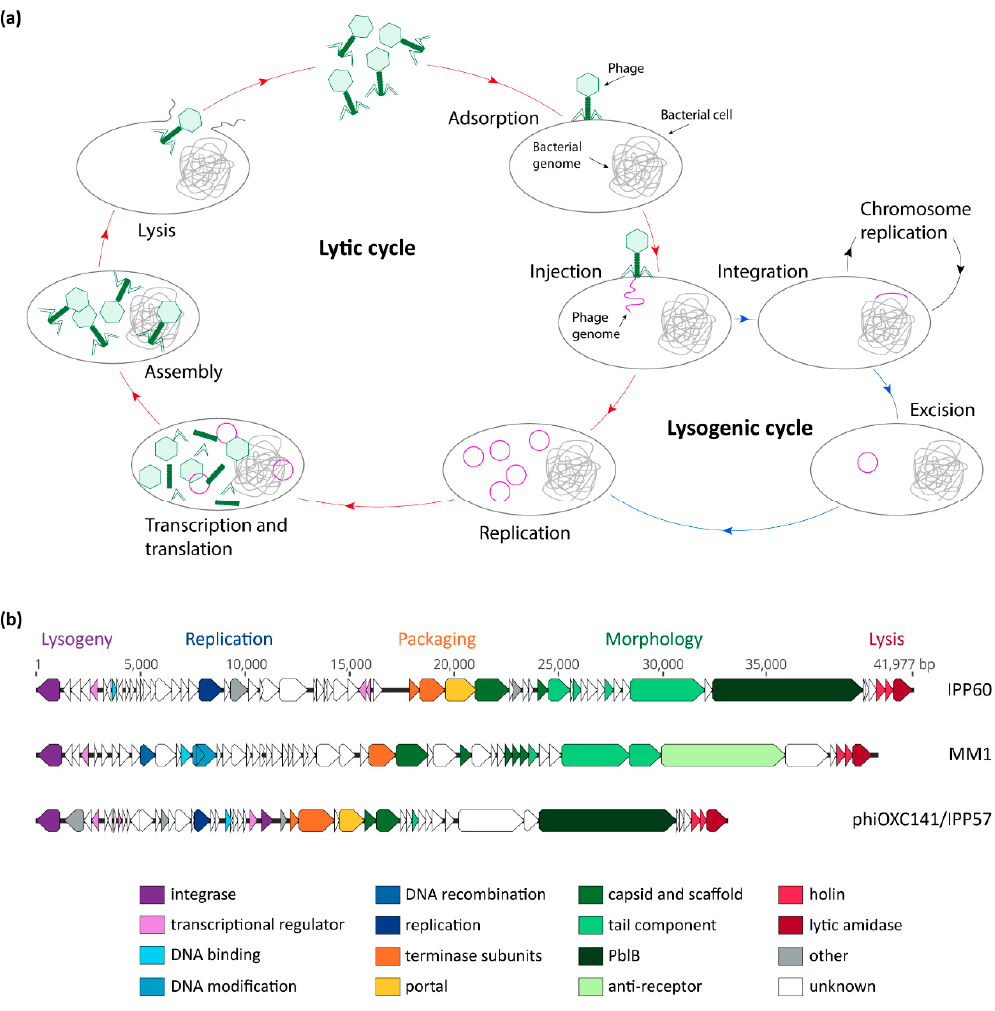
Figure 1. Bacteriophage life cycles and genetic modules. ( a ) General model of phage lytic and lysogenic cycles; ( b ) comparison of the sequences of three pneumococcal temperate phages: IPP60 (KY065496.1), MM1 (NC_003050.2), and phiOXC141/IPP57 (KY065494.1). Annotated open-reading frames are represented by arrows that point in the direction of transcription, and are color-coded according to their putative function.